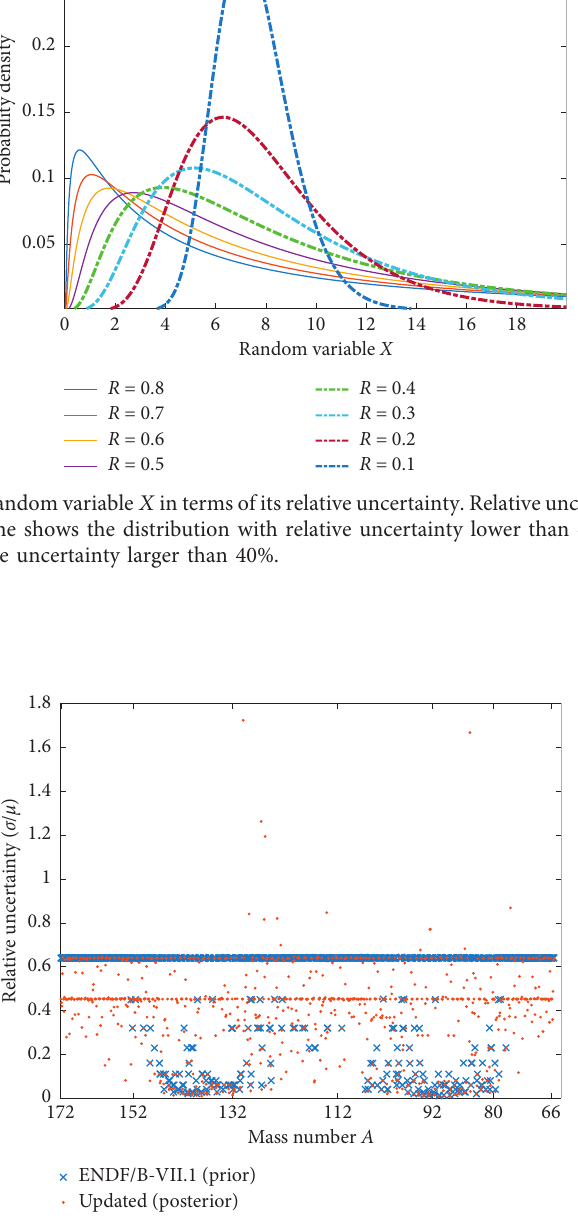
Figure 9: Relative uncertainties of prior and posterior independent yields in ENDF/B-VII.1 of fission products. These fission products are grouped with their corresponding mass number and the first mass numbers are labelled in this figure [30]. The increased relative uncertainty fission products are Ag130m0, Cd129m0, Sn127m1, Cd126m0, In126m0, Sb124m1, Zn123m1, Ag115m0, Y93m1, Y93m0, Se85m1, and